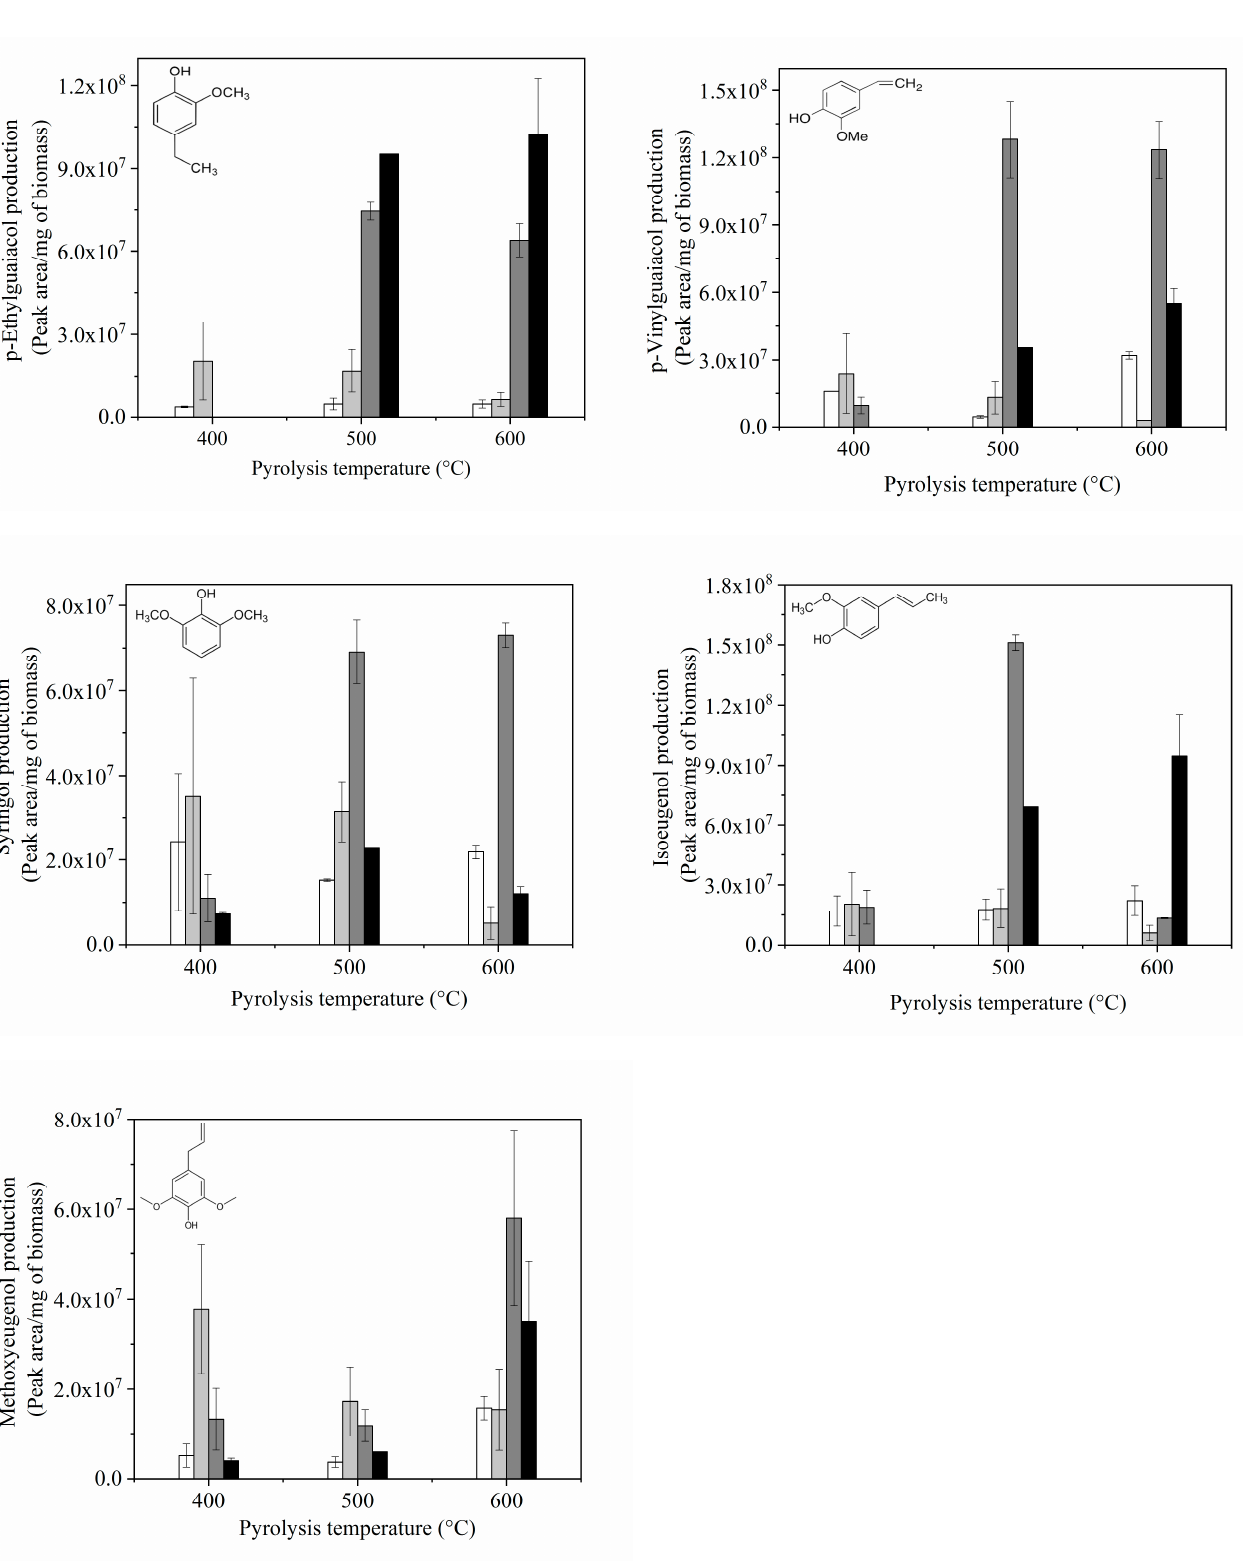
Figure 11. Formed phenolic compounds from coffee husks as a function of pyrolysis temperature and pretreatment acid type. Symbols: (cid:3) Untreated biomass; (cid:4) biomass pretreated with acetic acid; (cid:4) biomass pretreated with HNO 3 (0.1%)/H 2 SO 4 (0.1%); biomass pretreated with H 2 SO 4 (0.1%).